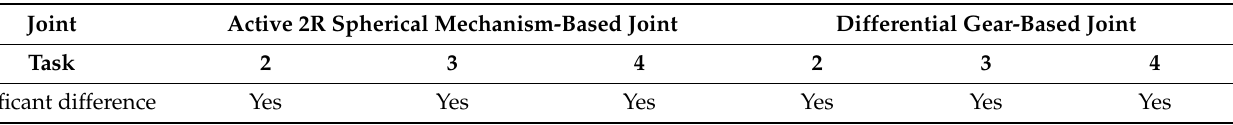
Table 2. Results of the statistical analysis of the two control modes in tasks